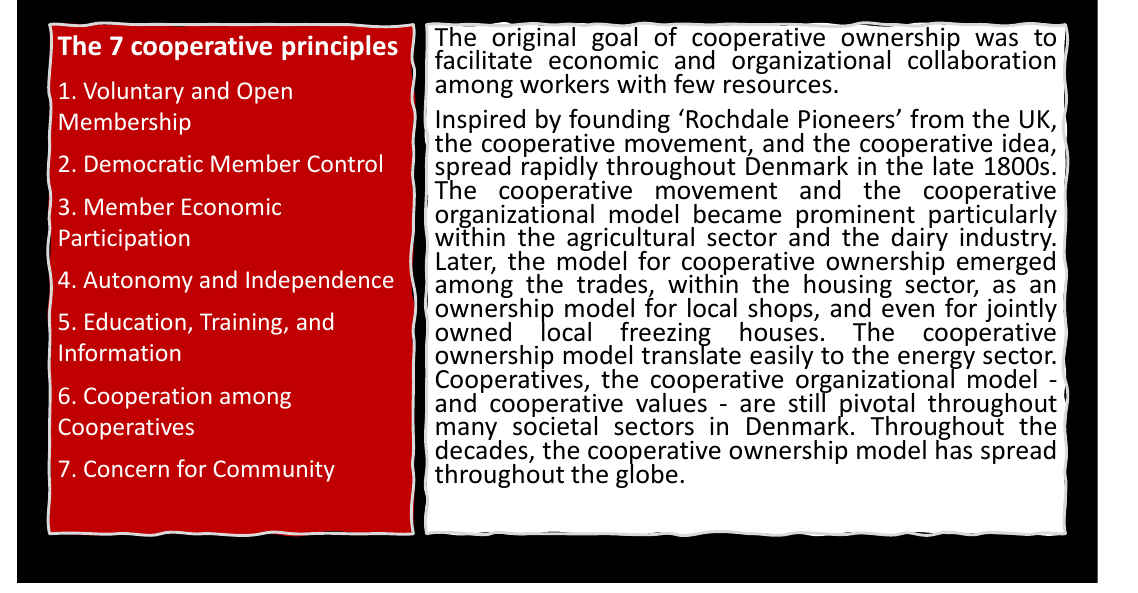
Figure 3. The 7 cooperative principles. Source: [36].